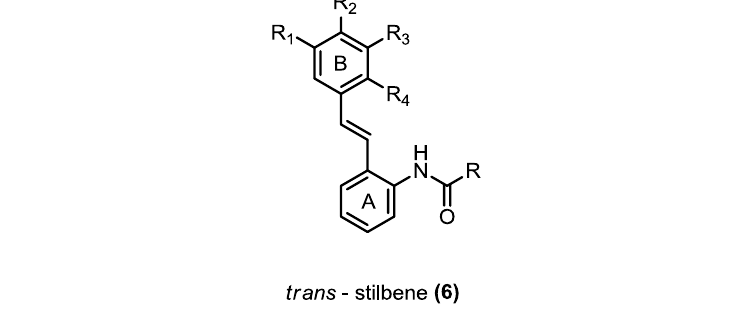
Scheme 1. Chemical structures of o -carboxamido stilbene analogues mentioned in this study and general structure of the synthesized compounds ( 6a – 6s